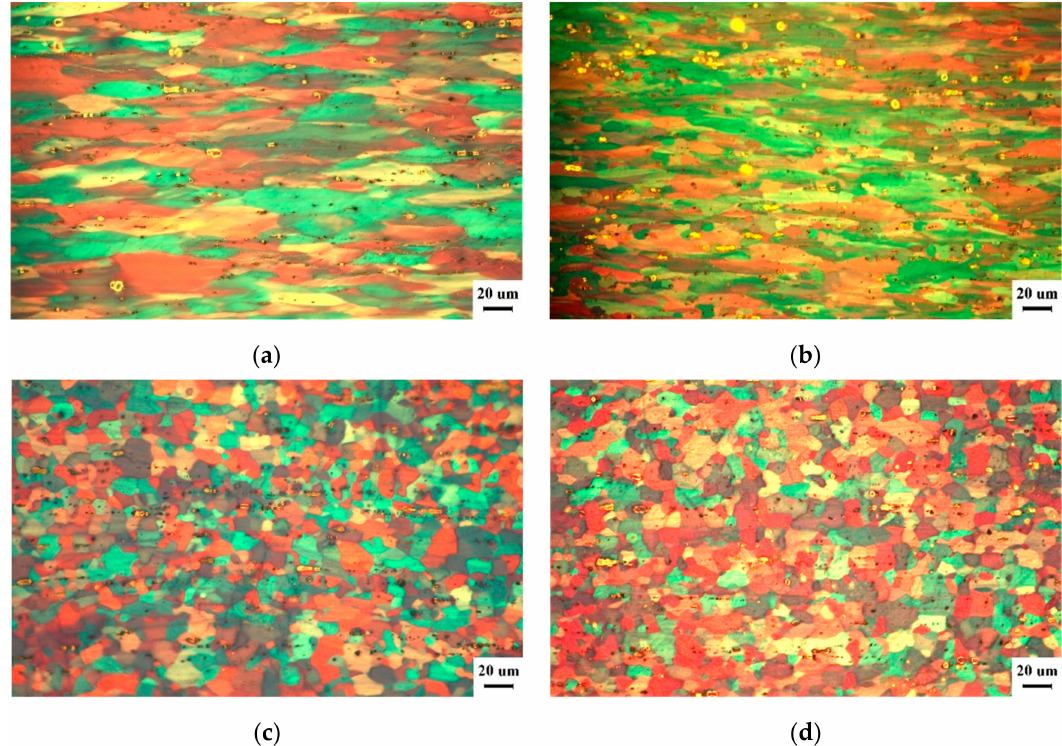
Figure 4. The polarized-light microstructure of a ϕ 6 mm thick 5056 aluminum alloy wire after 2-h